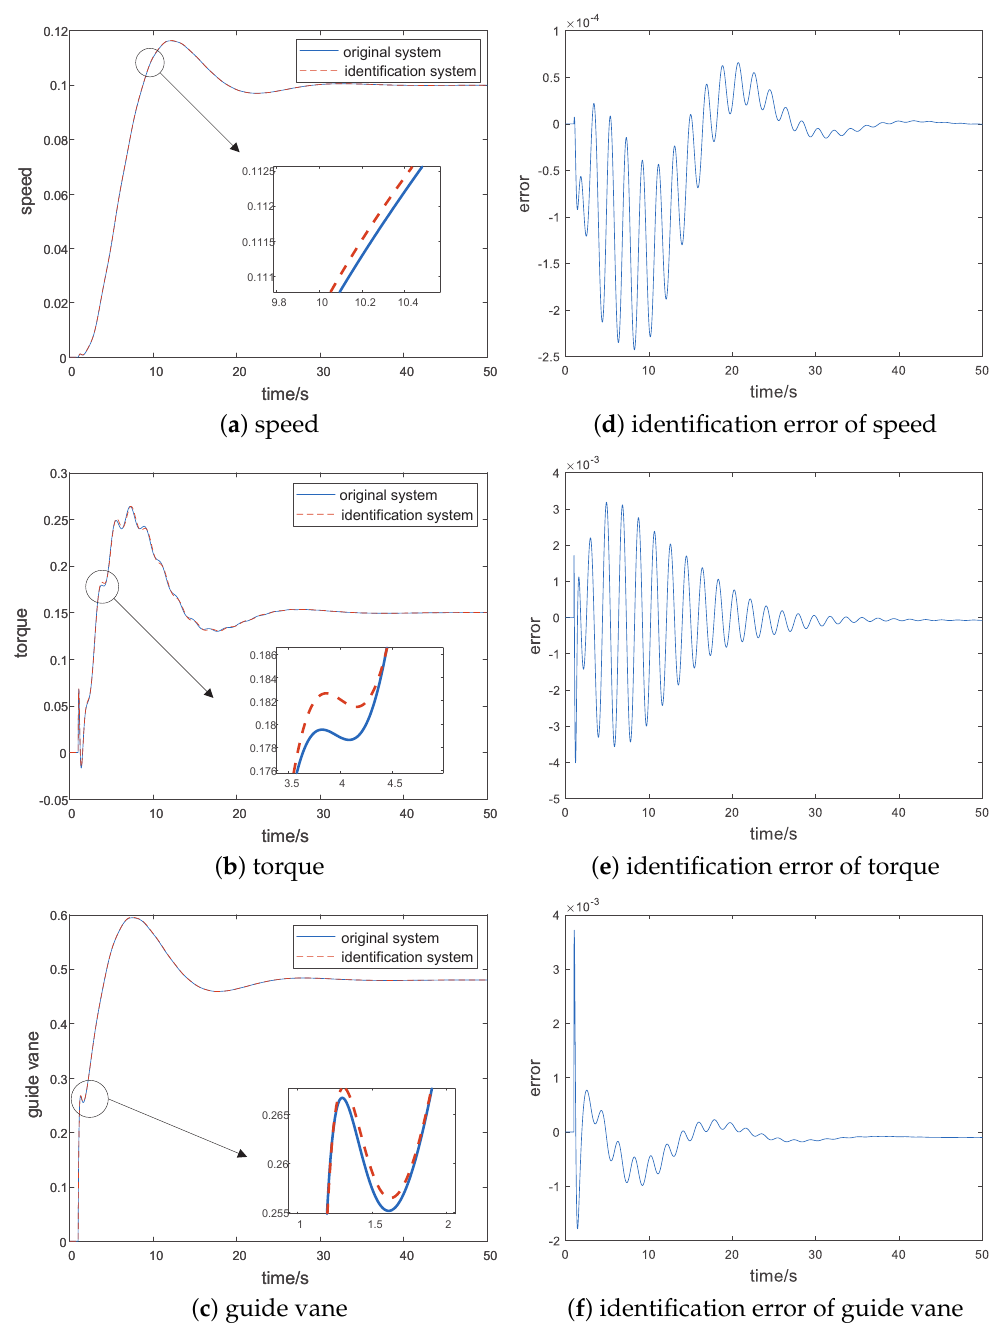
Figure 8. Comparison between the outputs of the three parts of the original and the identification systems under a 10% frequency